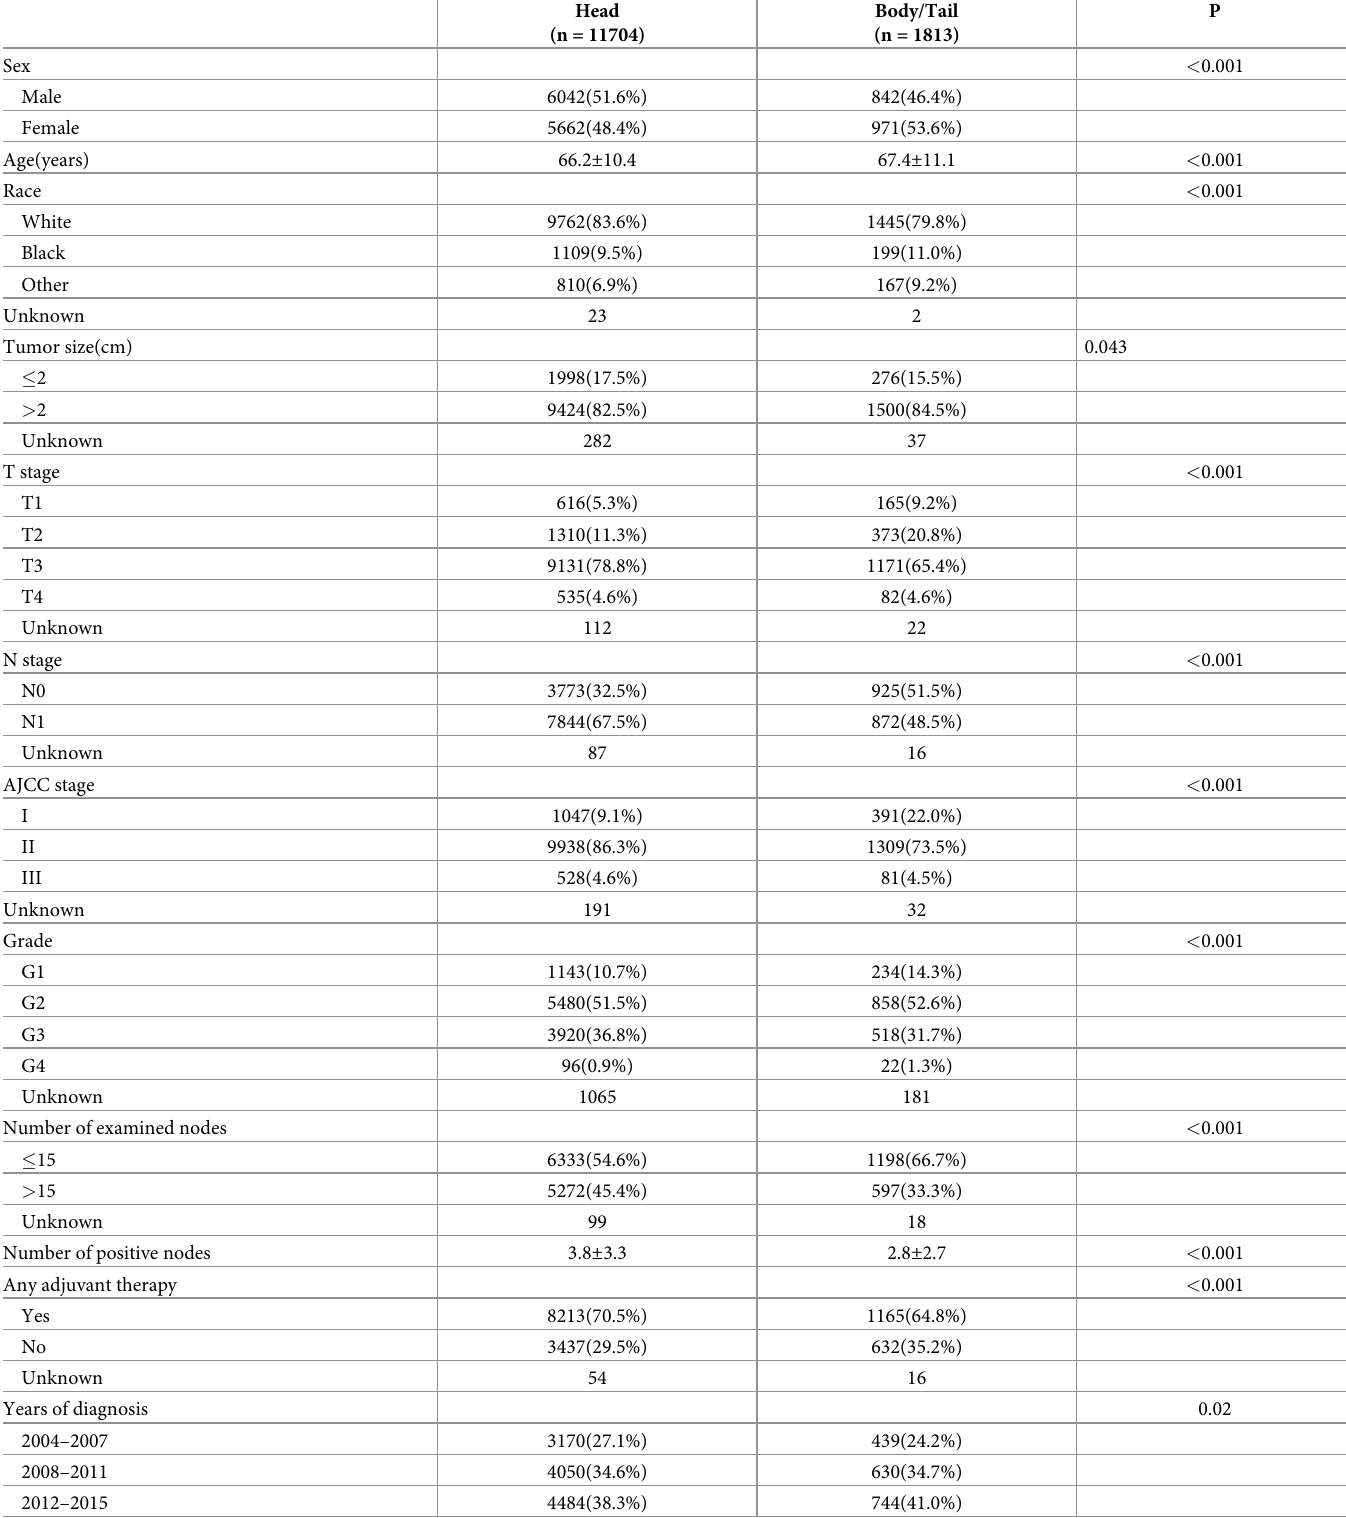
Table 2. Demographic and clinicopathological features of patients who underwent curative intent surgery for pancreatic